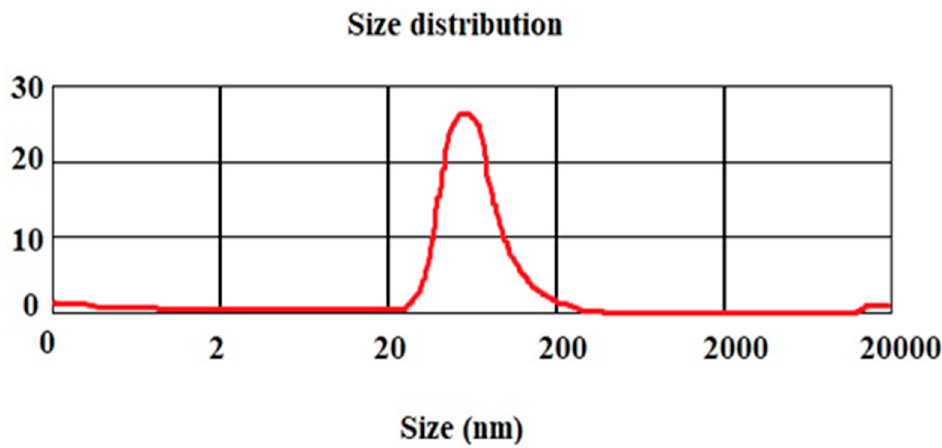
Figure 1. Mean particle size for hydroxyapatite–gelatin/curcumin nanocomposites .